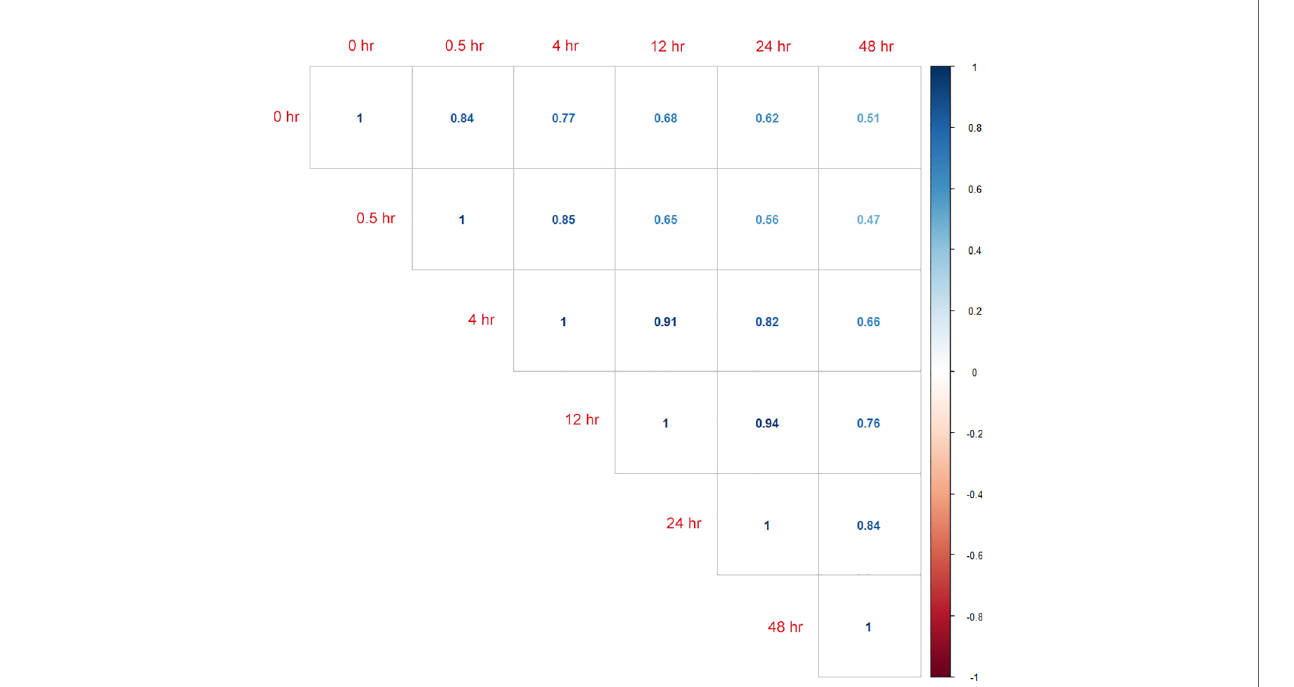
FIGURE 1 | Calculated correlation coef fi cients between RNA-seq data from samples of different time points (0_hour, 0.5_hour, 4_hour, 12_hour, 24_hour, and 48_hour) during